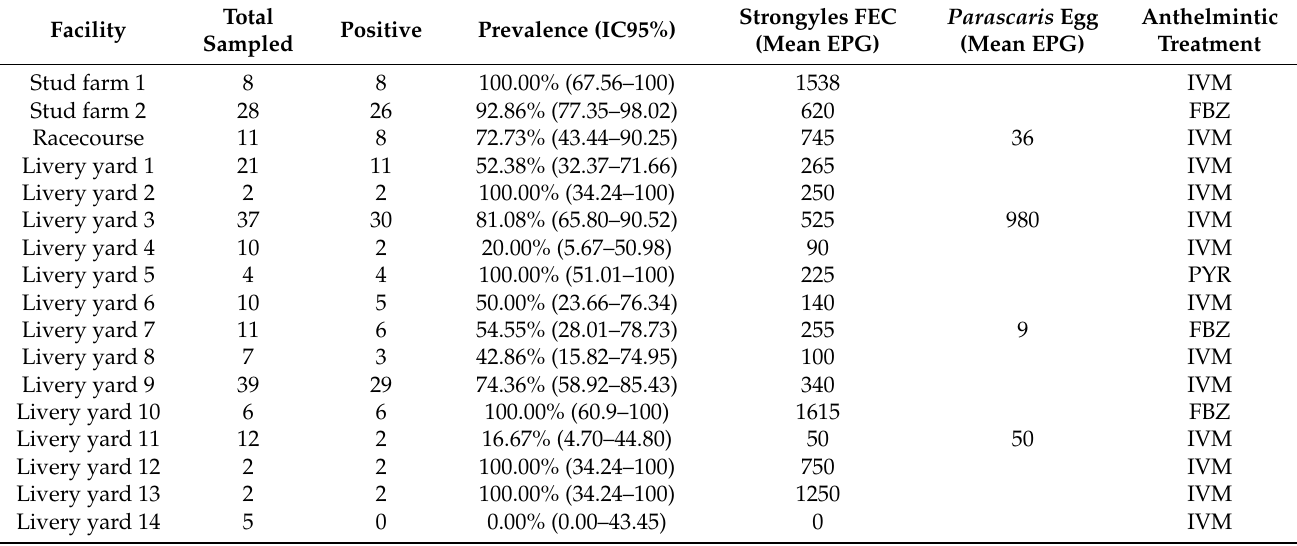
Table 2. For each of the 17 facilities enrolled in the study, we report the total number of sampled subjects, the number of subjects positive for strongyle eggs at T0, prevalence of infection, strongyle fecal egg count at T0 (mean egg per gram value, EPG), Parascaris spp. egg count (mean egg per gram value, EPG) and type of treatment (fenbendazole (FBZ), pyrantel pamoate (PYR) or ivermectin